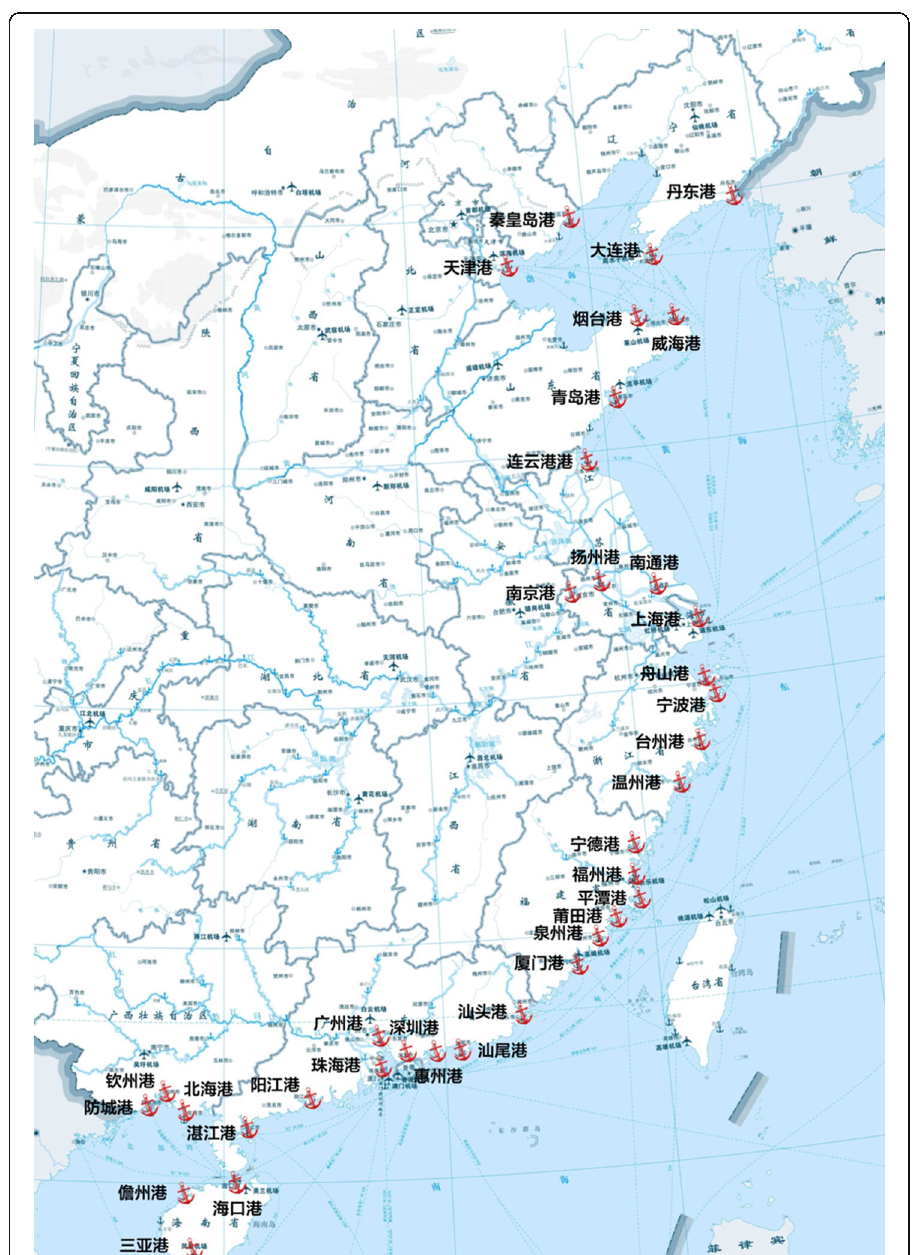
Fig. 2 The selected coastal cruise